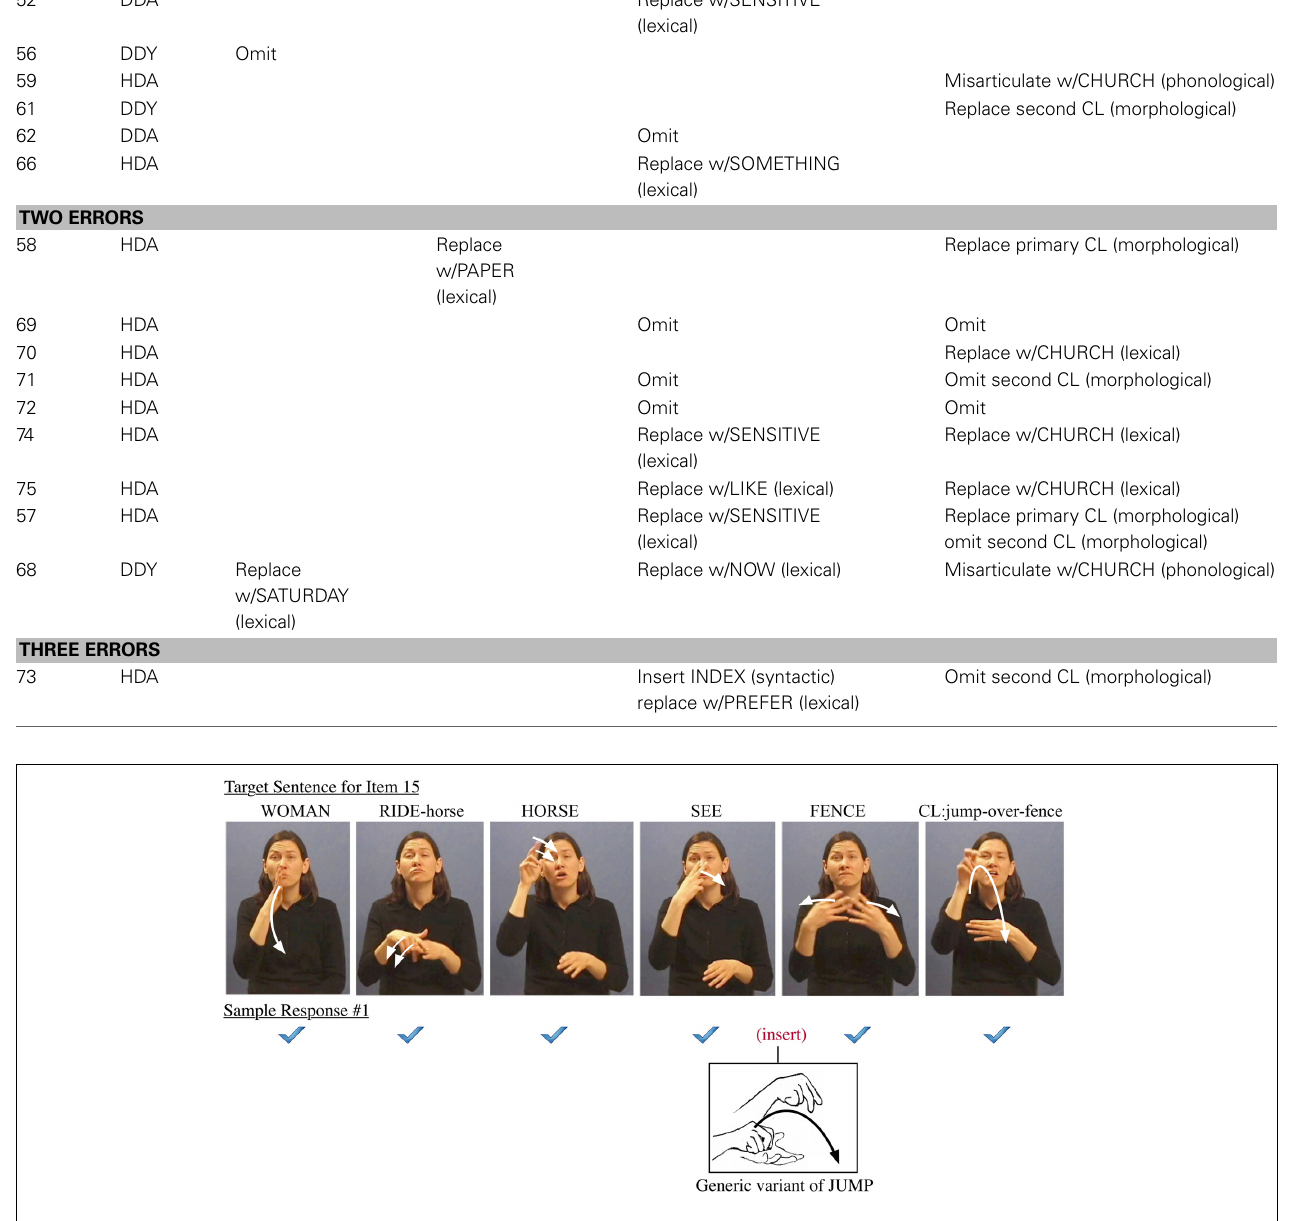
FIGURE 6 | Example of error made for sentence item